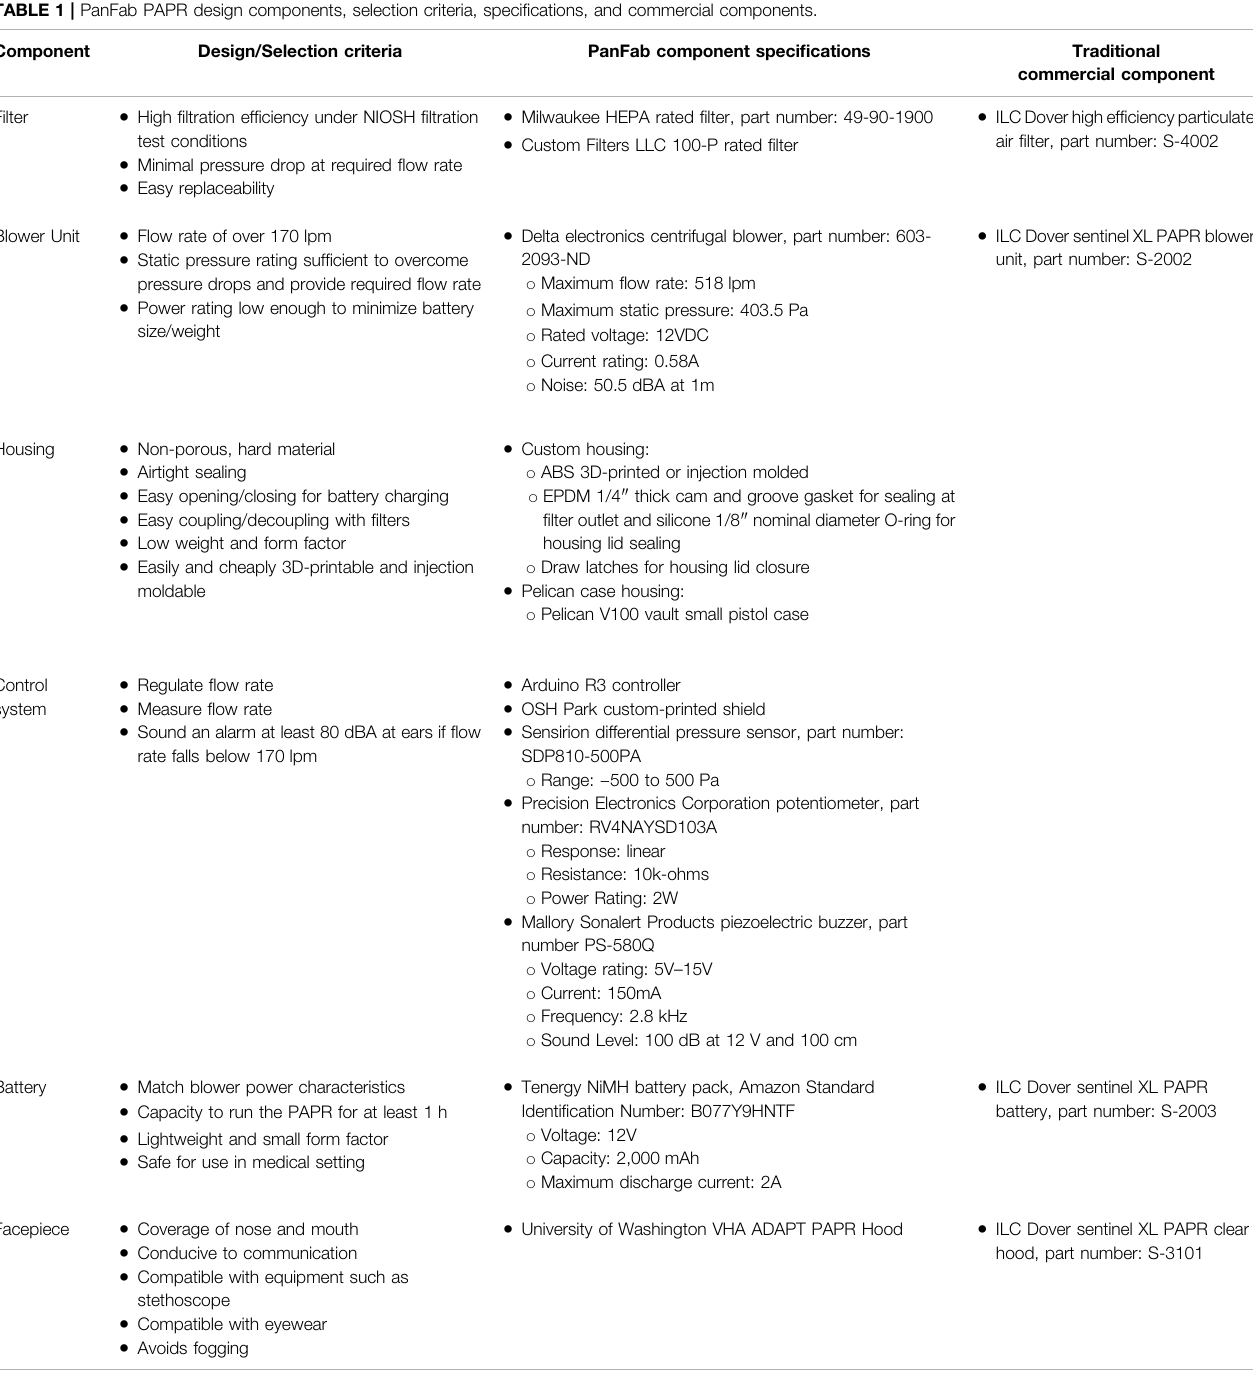
TABLE 1 | PanFab PAPR design components, selection criteria, speci fi cations, and commercial components. Component Design/Selection